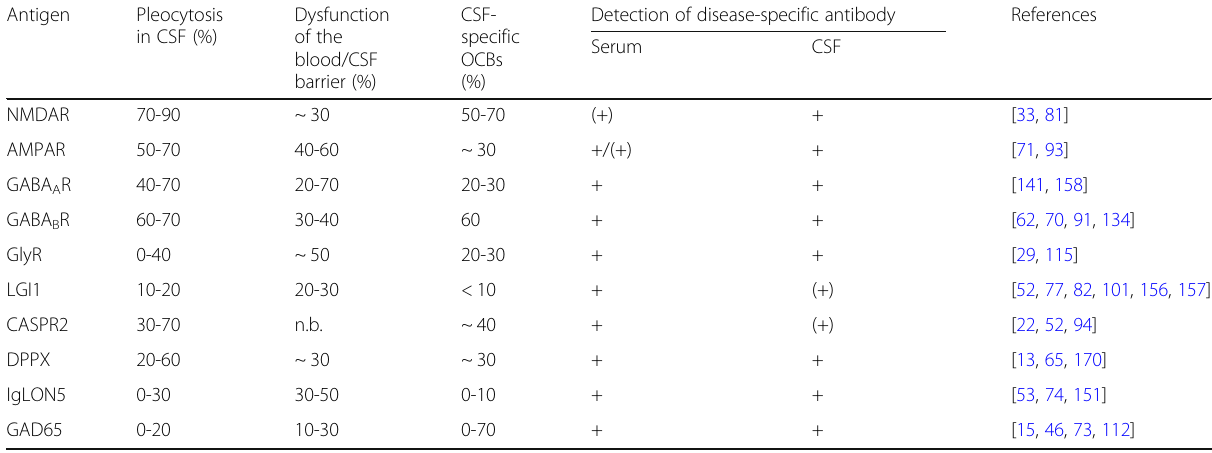
Table 15 CSF parameter of AE Antigen Pleocytosis in CSF (%)